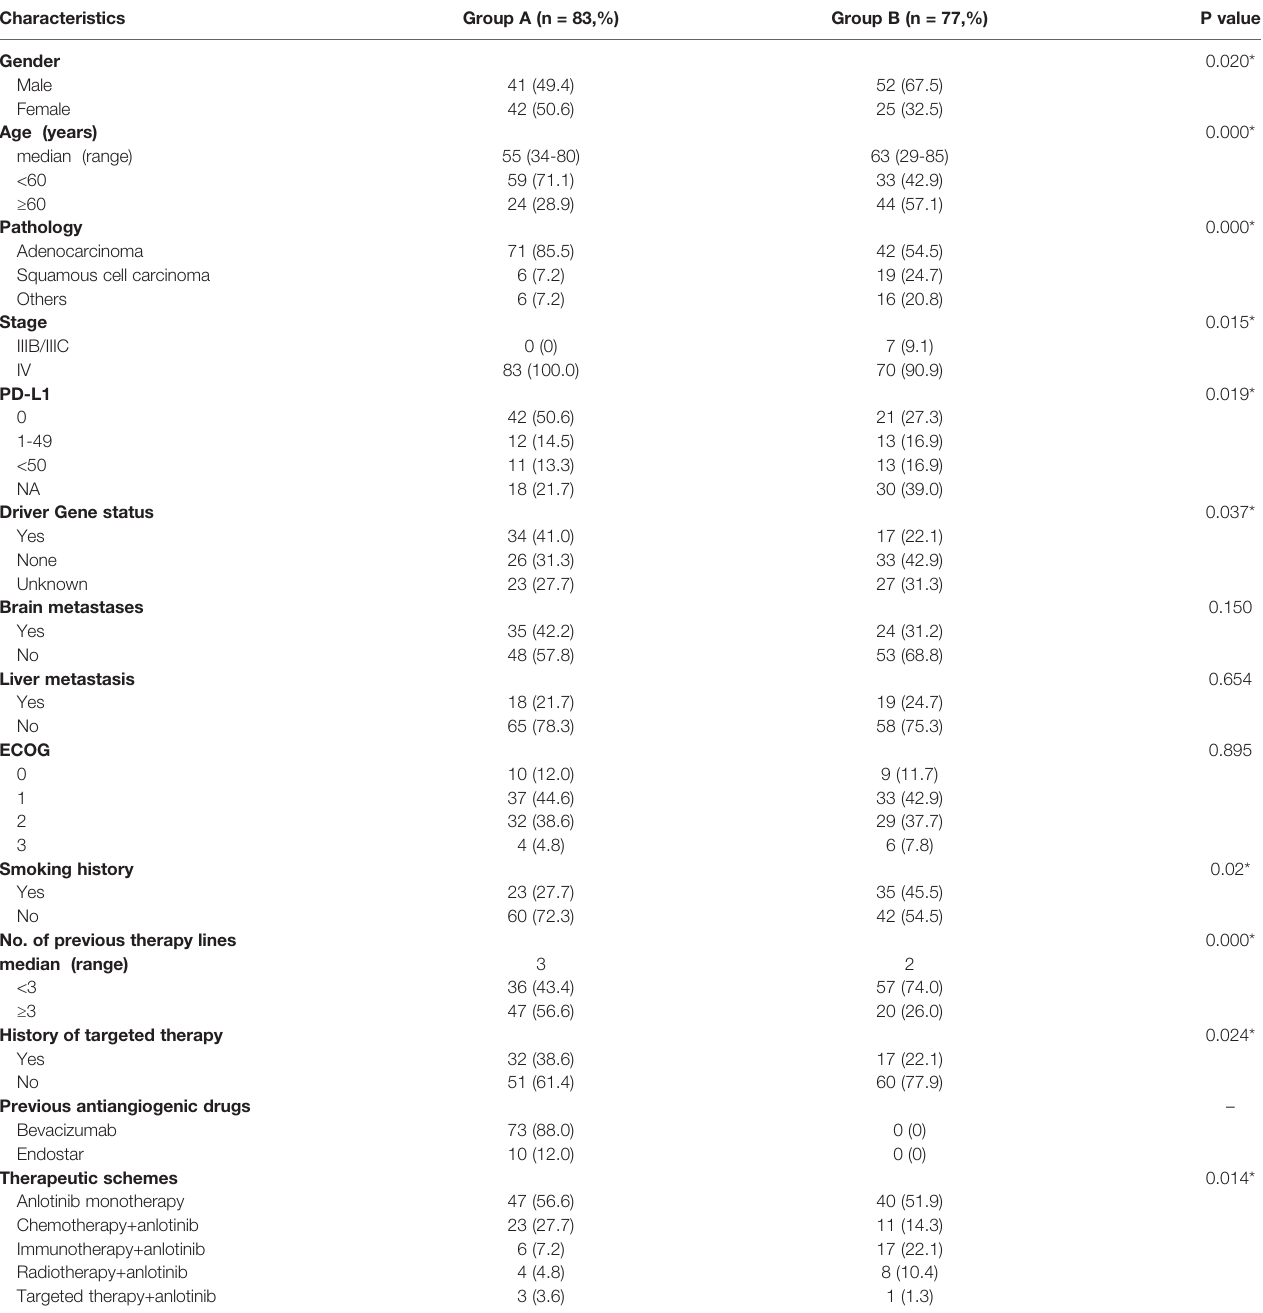
TABLE 1 | Baseline characteristics of patients.